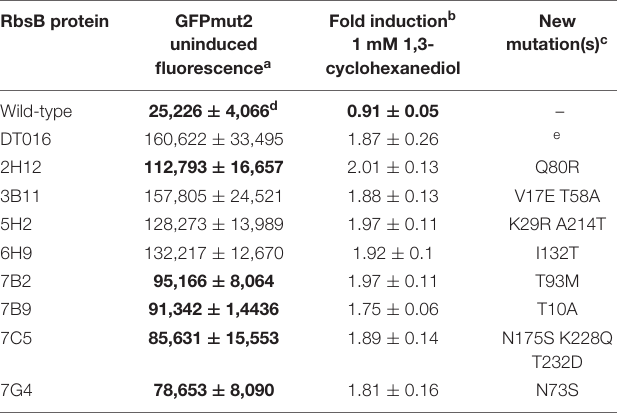
TABLE 2 | List of isolated mutants from RML002 and RML016 2nd round used for DNA shuffling. RbsB protein GFPmut2 uninduced fluorescence a Wild-type